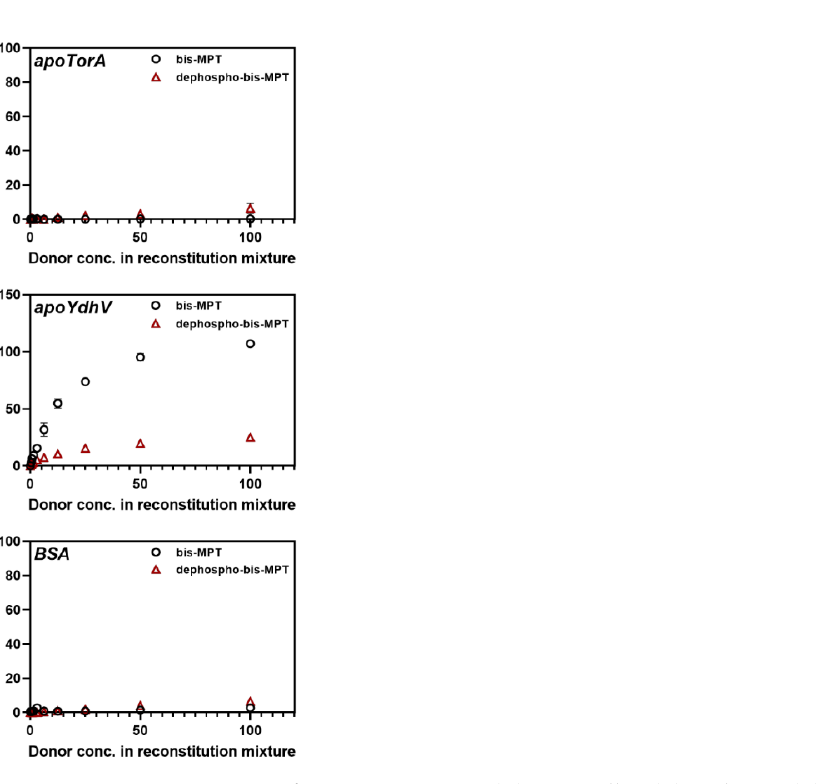
Figure 5. Bis-Mo-MPT content of 1.3 µM apo-TorA ( A ), apo-YdhV ( B ) and BSA ( C ) incubated with bis-Mo-MPT or dephospho-bis-MPT. Bis-Mo-MPT (circles) was directly isolated from YdhV. Dephospho-bis-Mo-MPT (triangles) was obtained after in vitro hydrolysis of the terminal bis-Mo-MPT phosphate group by alkaline phosphatase (AP). Bis-MPT and dephospho-bis-MPT were detected in form of their fluorescent oxidation product dephospho-FormA.